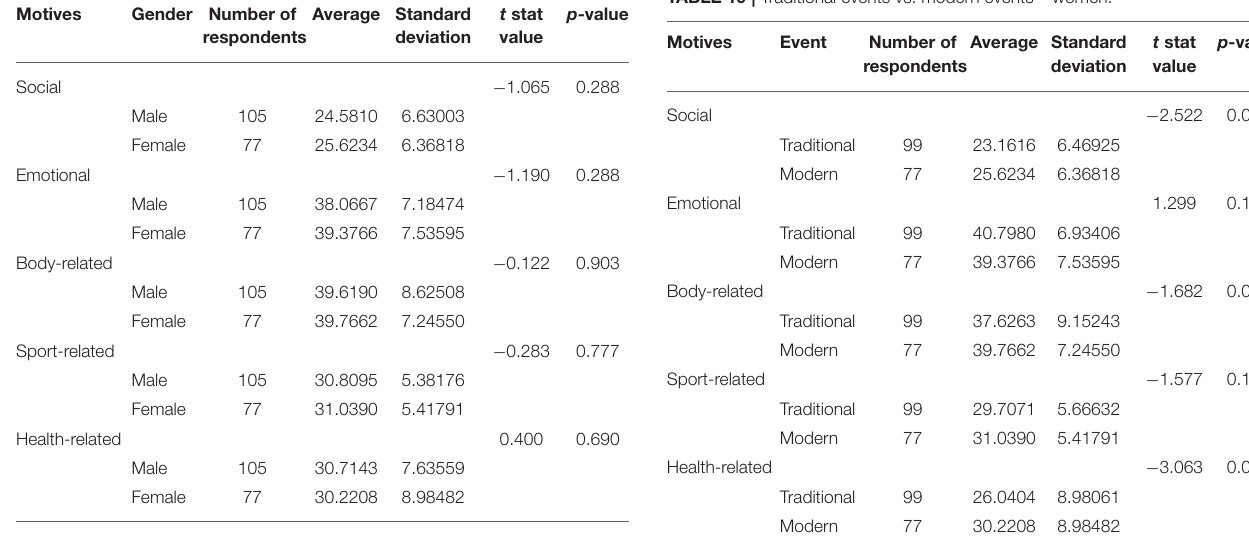
TABLE 19 | Traditional events vs. modern events –